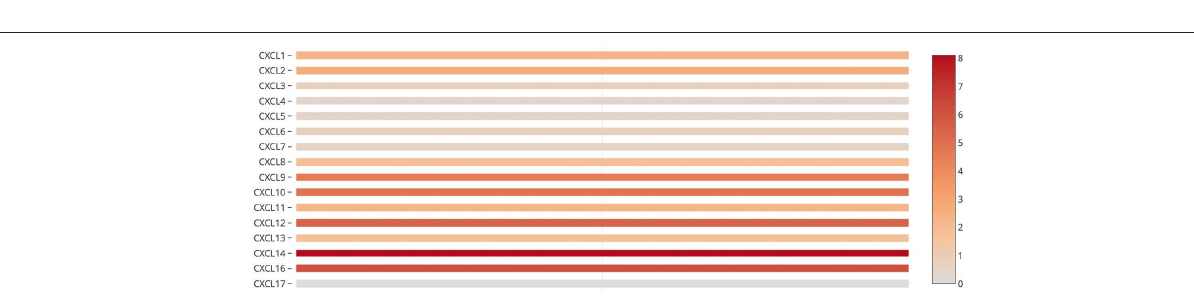
FIGURE 3 | The relative level of CXC chemokines in